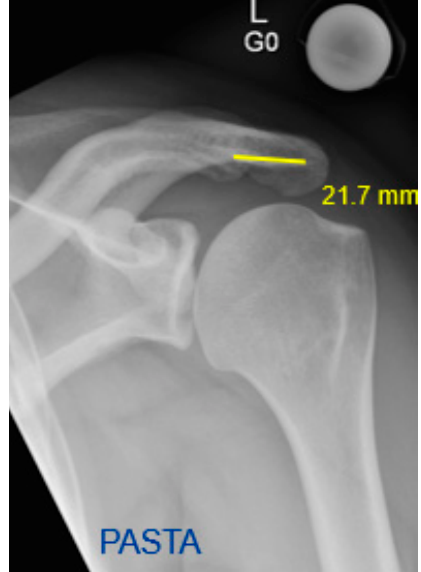
Figure 1. Left shoulder anteroposterior radiograph of the BURSA group indicating a “Short Sclerotic Line” (in yellow).